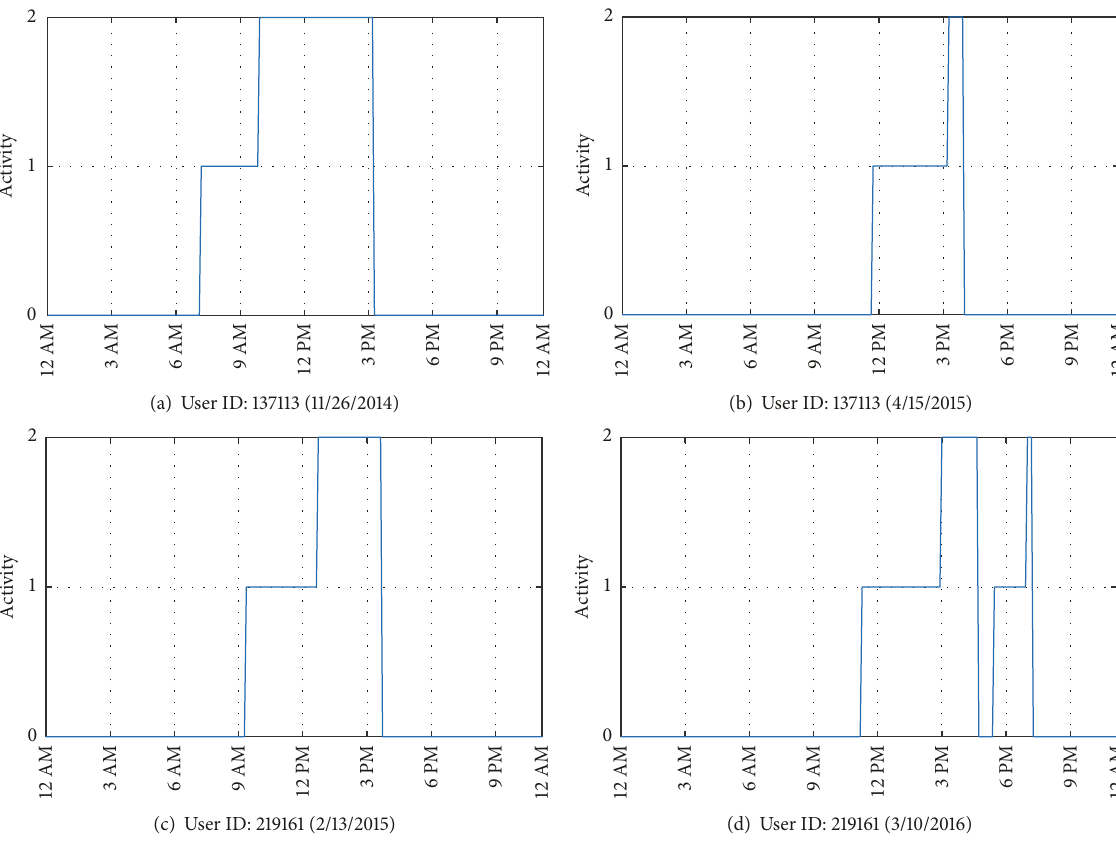
Figure 2: Observed charging patterns of PEV drivers in the sample (“0”—no activity, “1”—charging, and “2”—parking without charging).